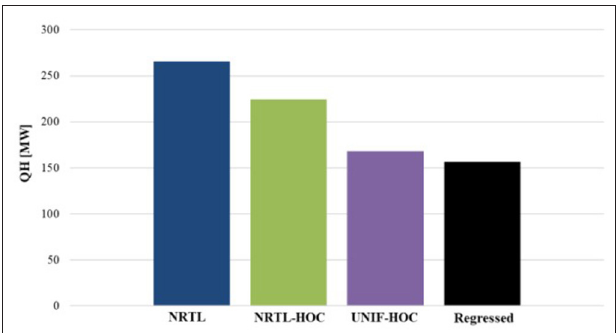
FIGURE 7 | Thermodynamic models vs. estimated reboiler duty.